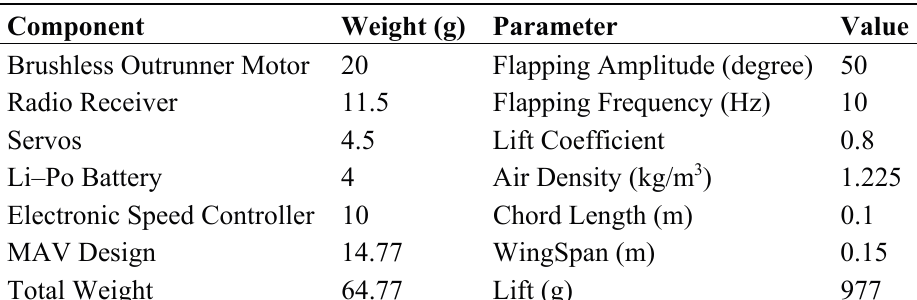
Figure 60. CAD design prototype 2. Table 8. Lift and weight